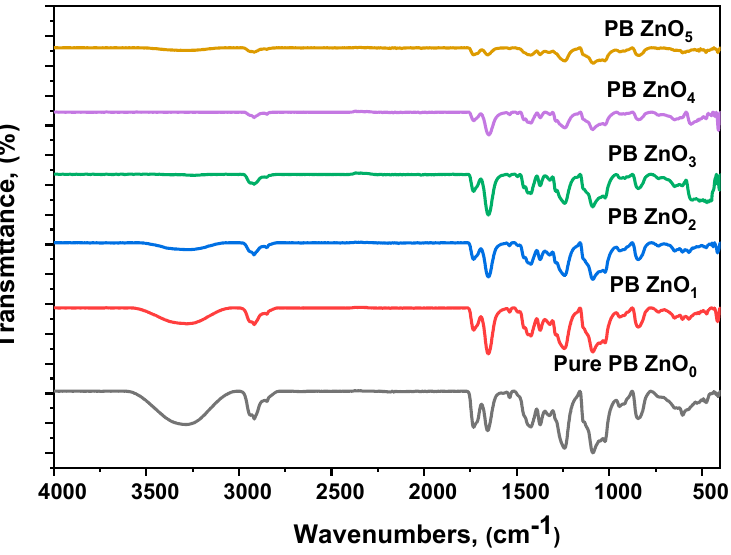
Figure 2. FT-IR transmittance spectra of (PVA-PVP) blend and ZnO polymeric nanocomposite films.